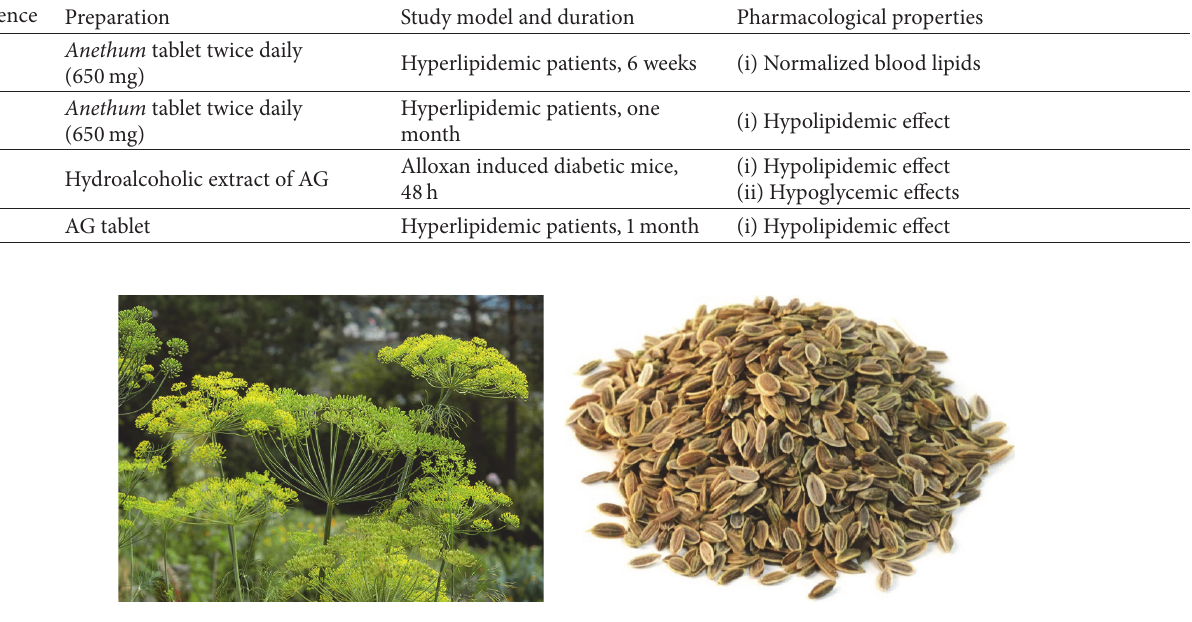
Figure 1: Plant and seed of